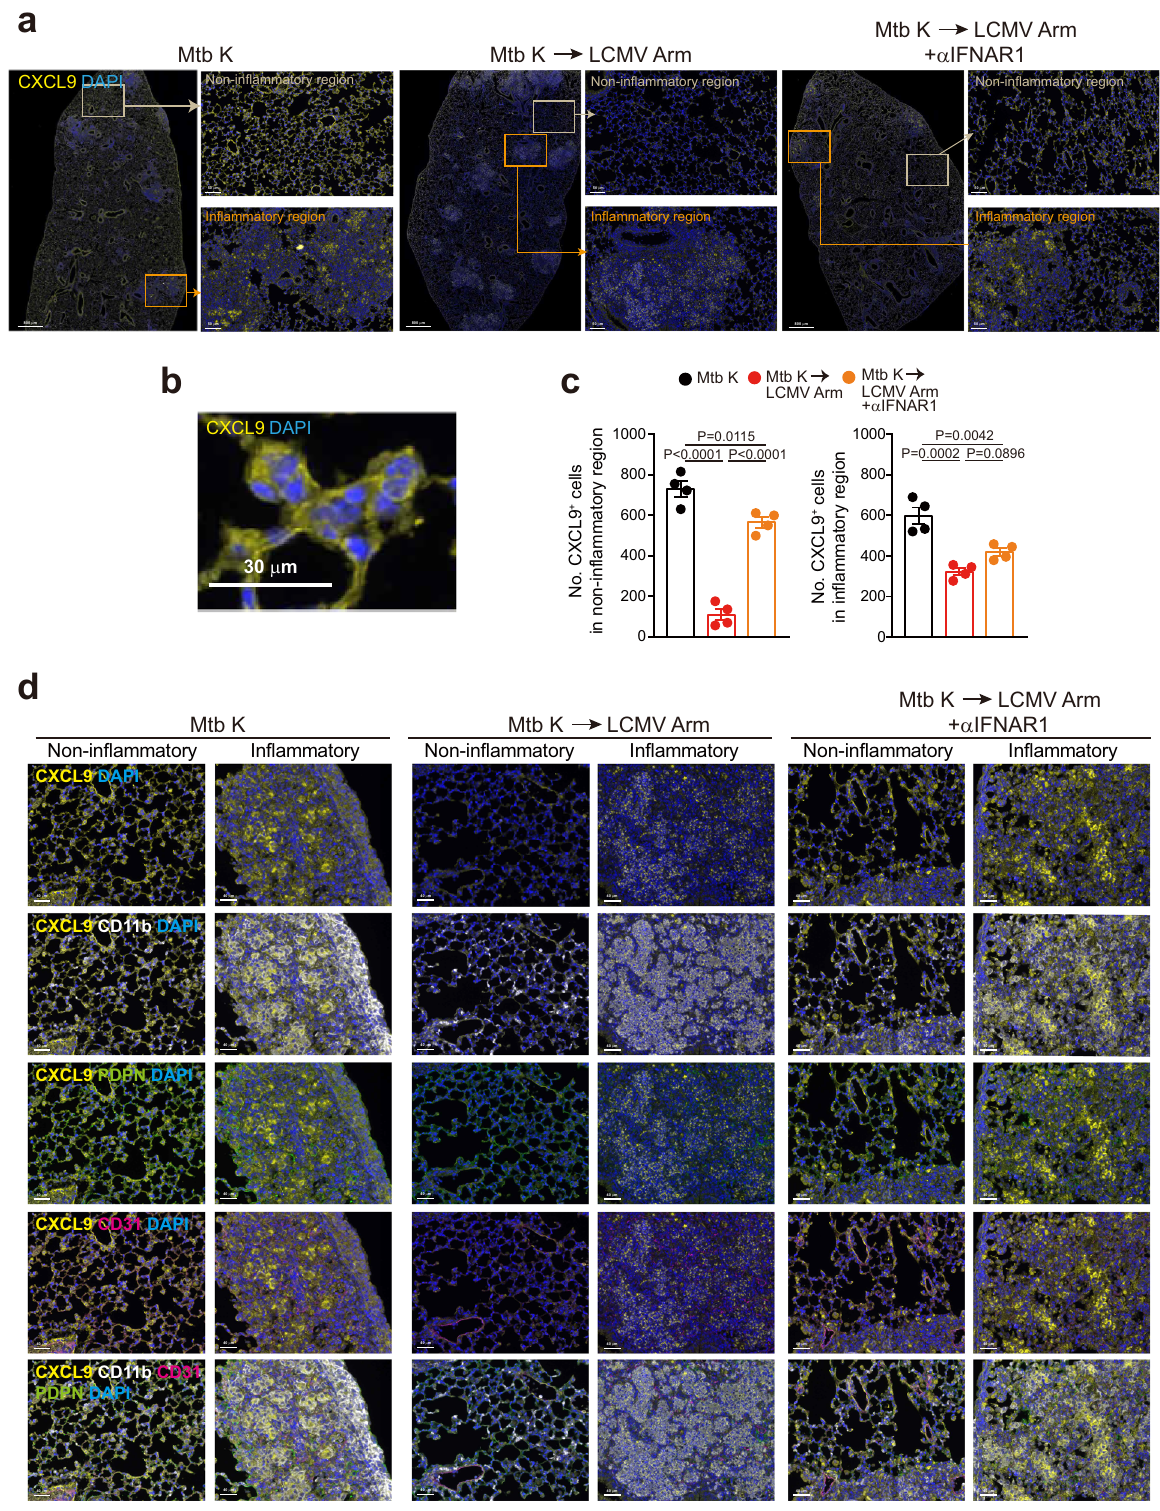
Fig. 5 Rescued CXCL9 expression through type I IFN receptor blockade in pulmonary regions. Seven days post LCMV infection, we analyzed CXCL9 expression in the lung by multiplex immuno fl uorescence staining. a Representative images of CXCL9 (yellow) immuno fl uorescence and DAPI (blue) staining in nonin fl ammatory or in fl ammatory regions of lung tissues. Scale bars, 800 μ m or 50 μ m. b Representative images of CXCL9 and DAPI staining in lung tissues. Scale bars, 30 μ m. c The number of CXCL9 + cells in each randomly selected region was counted and is summarized in the bar graphs ( n = 4). One-way ANOVA with post hoc Tukey ’ s test. Plots show the mean ± SEM. d Representative images of CXCL9 (yellow), CD11b (white), CD31 (magenta), and PDPN (green) immuno fl uorescence and DAPI (blue) staining of lung tissues. Scale bars, 40 μ m. The data are representative of single experiments. Source data are provided as a Source Data fi